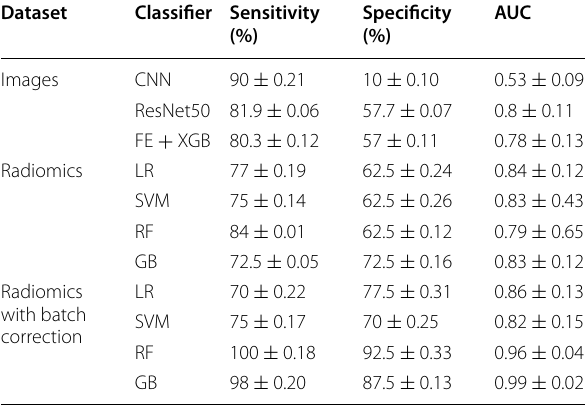
AUC area under the curve, CNN convolutional neural networks, FE feature extraction, XGB Xgboost, GB gradient boosting, LR logistic regression, RF